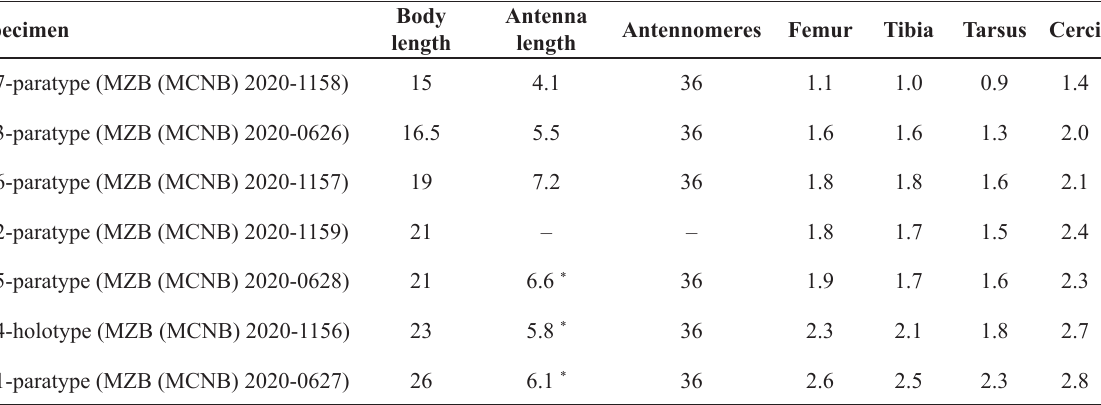
Table 5. Mueggenjapyx brehieri Sendra & Komerički gen. et sp. nov., length of the body, antennae and femur, tibia and tarsus of the metathoracic leg (all units in mm except number of antennomeres). * = telescoped